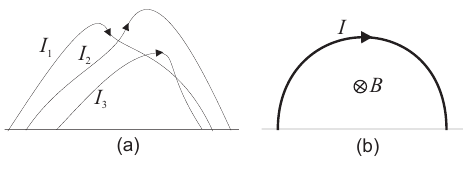
Fig. 1. Sketch of a complex coronal electric current system (a) , and its approximation by the line current (b) . The magnetic field B encompassed by the line current and the solar surface is indicated.